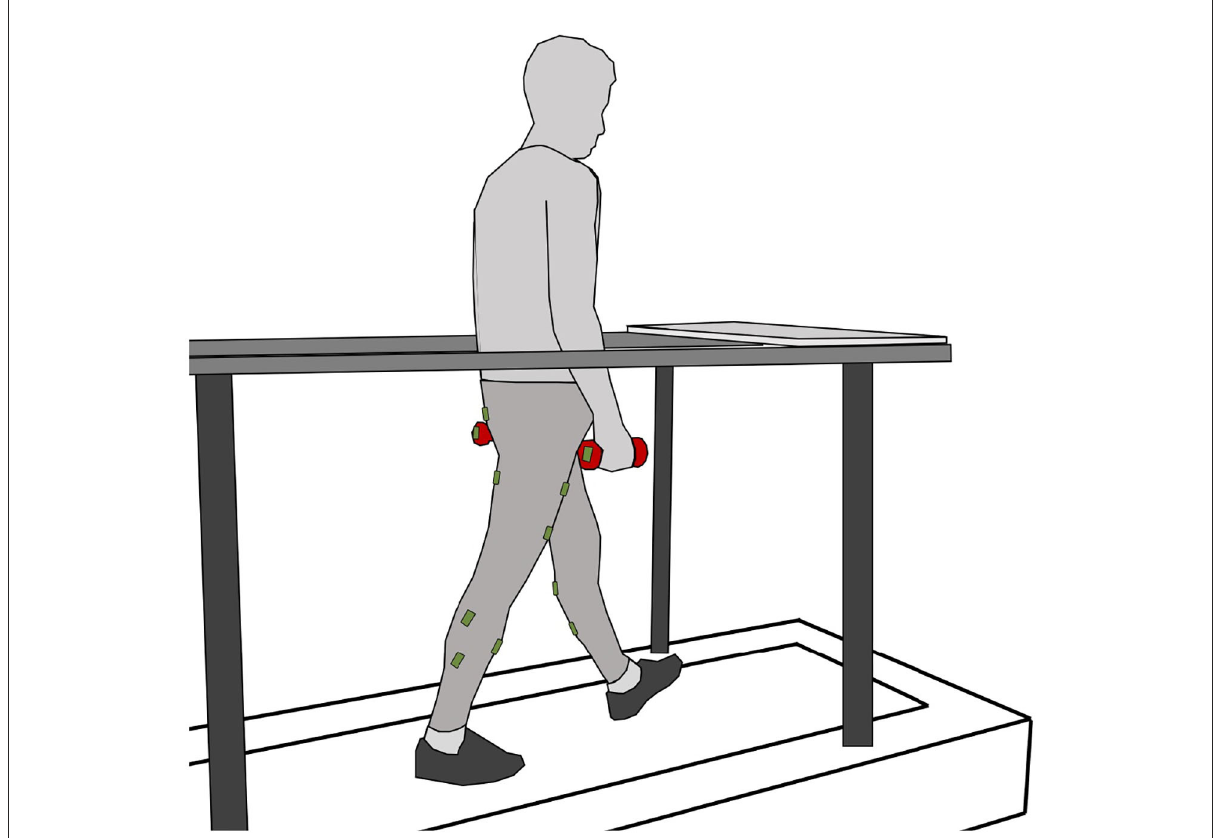
FIGURE1 Subject on the treadmill while walking with one vinyl-coated dumbbell in each hand (red). The plate in front of the treadmill on the handrail is used to pick up or release the weights. Seven sensor units including EMG and gyroscopes were placed on the skin of each leg (green). One sensor unit was used only as a gyroscope and placed on each